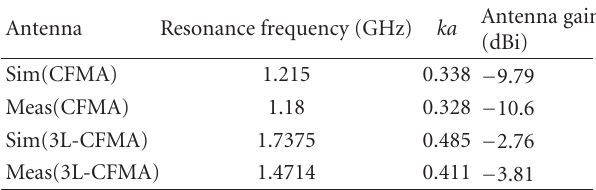
Table 3: The antenna characteristics at the resonance frequency. Antenna